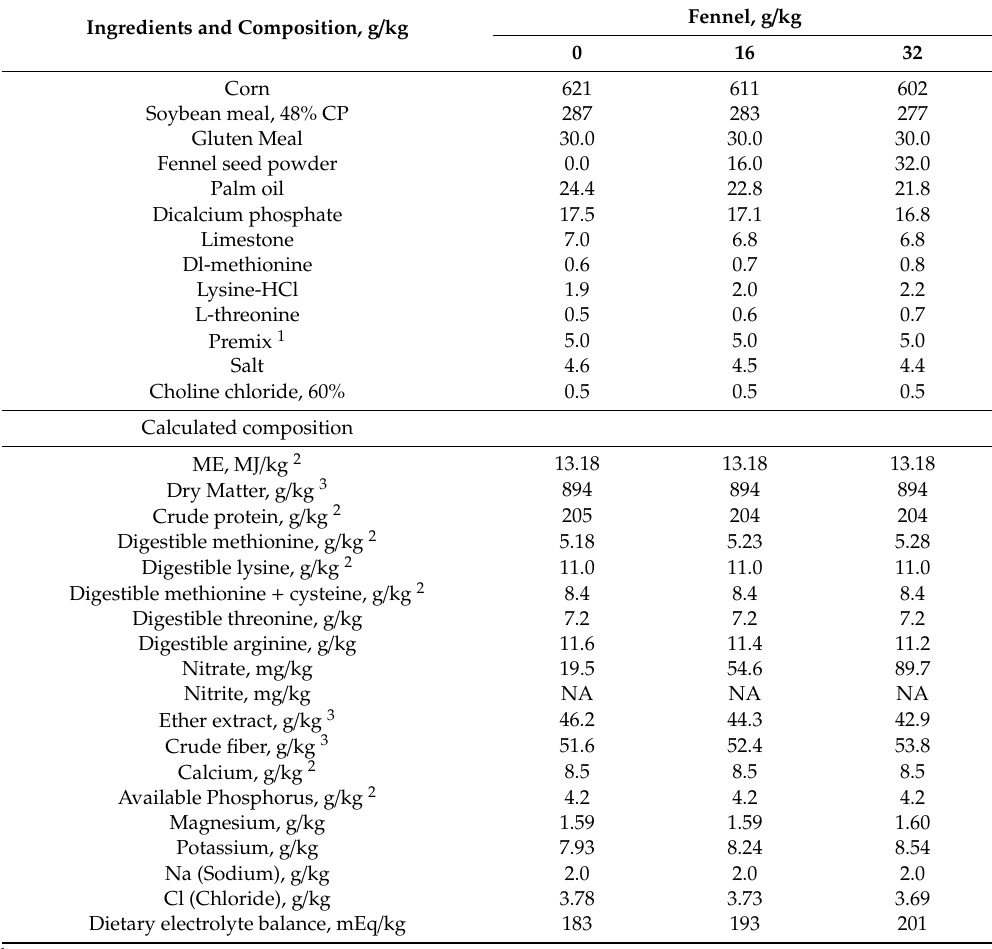
Table 1. Ingredients and nutrient composition of finishers (days 19 to 41), diets as fed basis. Ingredients and Composition, g /